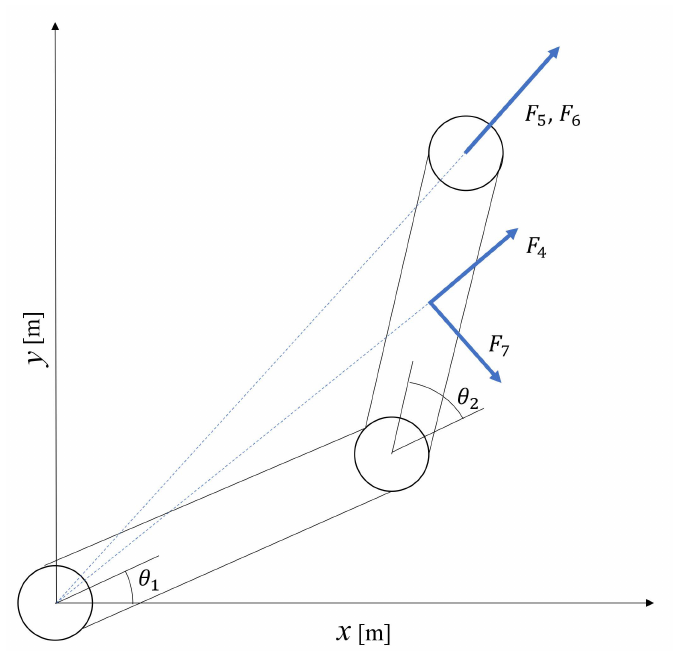
Figure 3. Force exerted on the right arm of the dual arm